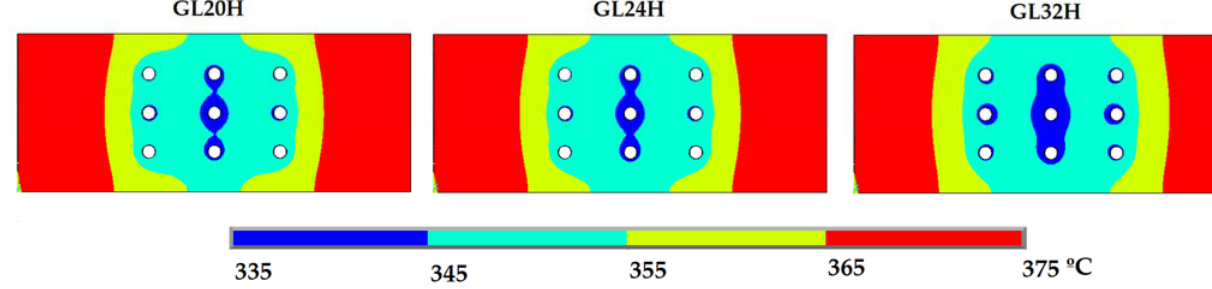
Figure 17. Temperature in the plane of wood in contact with the steel plate for the time of 300 s.